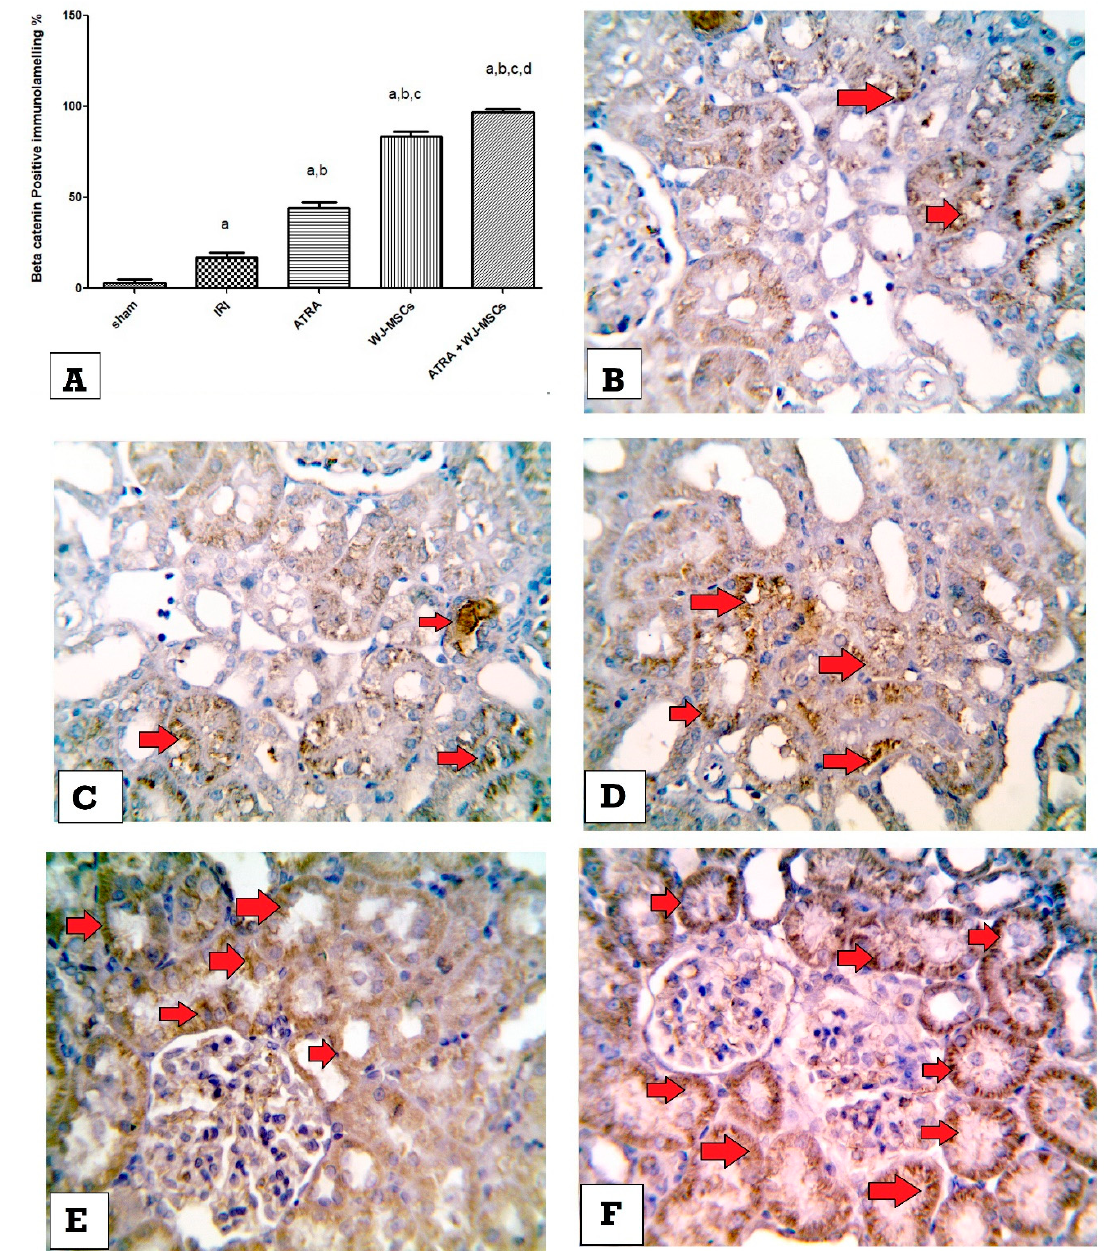
Figure 5. Expression of β -catenin in kidney tissues in day 5 group . ( A ) Percentage of β -catenin pos- itive cells in different studied groups. a significant vs. sham group, b significant vs. IRI group, c sig- nificant vs. ATRA group, d significant vs. WJ-MSCs group. Microscopic pictures of immunostained tissues showing very minimal brown expression of β -catenin in renal tubular epithelial cells and glomerular cells of sham group (red arrows) ( B ), mild brown expression of β -catenin in renal tu- bules of the IRI control group (red arrows) ( C ), mild to moderate expression of β -catenin in renal tubules of ATRA group (red arrows) ( D ), moderate expression of β -catenin in renal tubules of WJ- MSCs group (red arrows) ( E ), and high expression of β -catenin in renal tubules of the ATRA + WJ- MSCs group (red arrows) ( F ) (high magnification 400×).